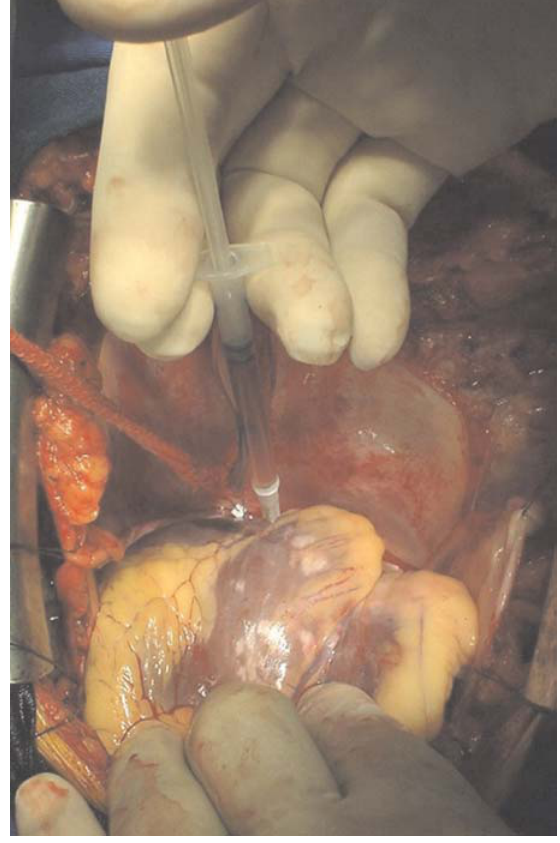
Figure 1 - Intramyocardial injection of autologous bone marrow cells during CABG in non-bypassable areas of ischemic, viable myocardium.